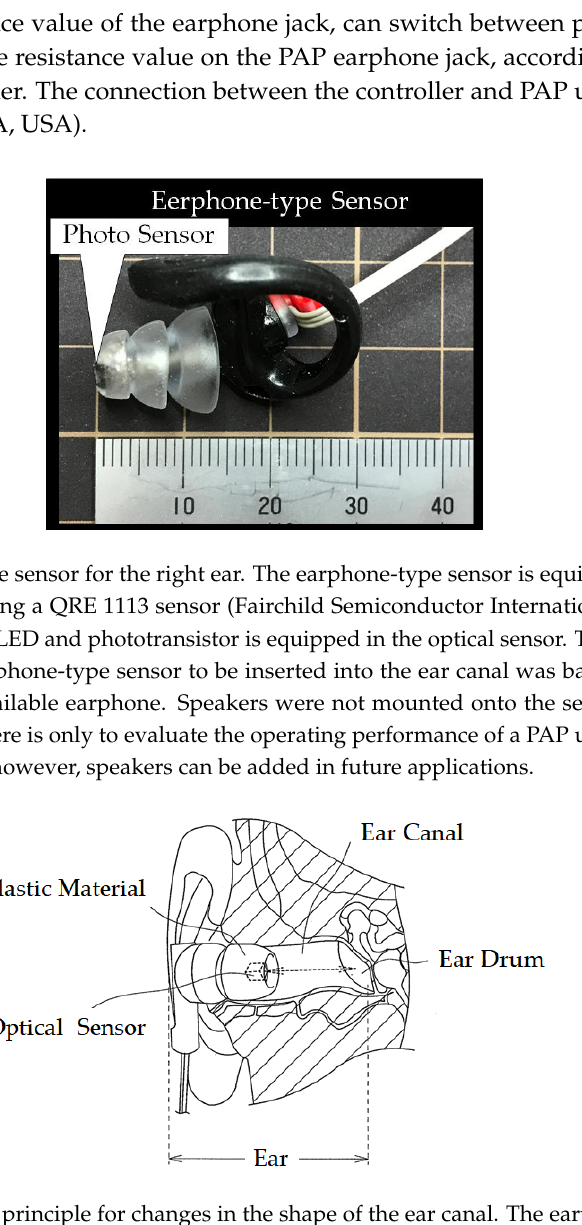
Figure 4. Measurement principle for changes in the shape of the ear canal. The earphone-type sensor receives the light emitted from the optical distance sensor that is reflected back by the eardrum and ear canal. During movement of the tongue, the shape of the ear canal changes, which alters the distance between the optical distance sensor and the eardrum and ear canal. The amount of light received changes over time in association with this change in distance.